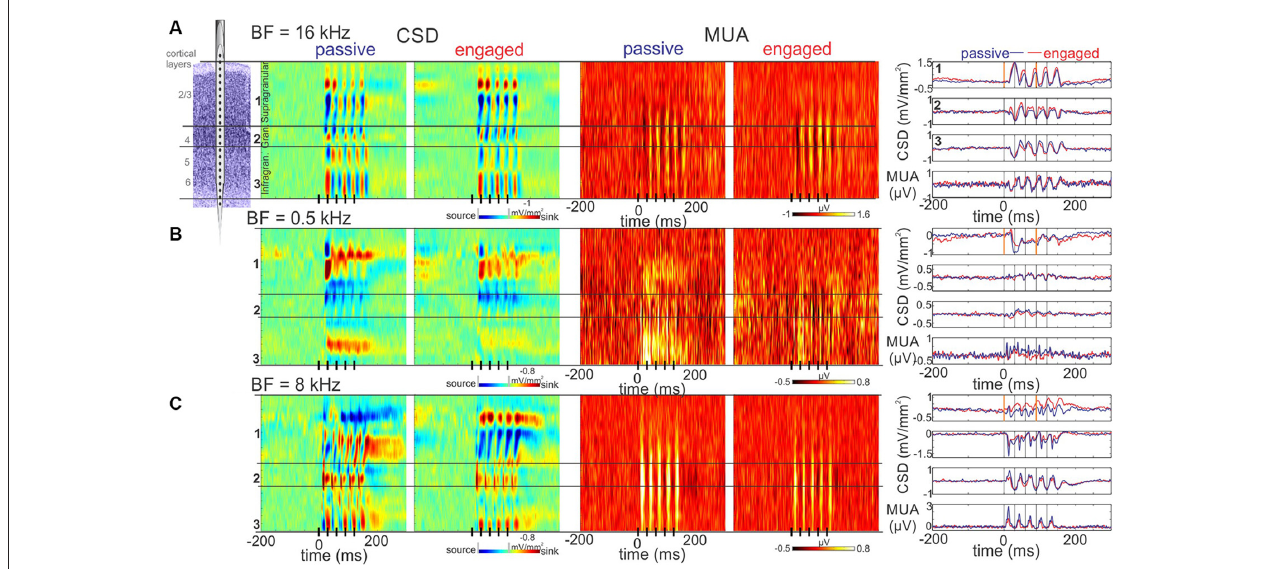
FIGURE 3 | Representative laminar response profiles. (A) Color-maps to the left display laminar Current source density (CSD) profiles in response to click-trains from an A1 site with a BF of 16 kHz (no suppression group). The boundaries of the supragranular, granular and infragranular layers are marked by black horizontal lines. The click-train is represented by black lines on the x -axis. Note that there appear to be sink (red)-source (blue) pairs representing active and associated passive currents in each of the layers. Color-maps to the right display the concomitant laminar MUA responses, which show a somewhat larger amplitude response in the engaged condition. The upper three traces to the right of the color-maps show CSD responses from the supragranular, granular and infragranular electrode locations marked by numbers to the left of the CSD maps (for the selection of these see “Materials and Methods” Section). The apparently largest response amplitude difference in passive vs. engaged condition is at the supragranular electrode location. Note that at stimulus onset, the baseline is negative-trending (especially in the engaged condition), and at the onset of the fourth click (orange line at 90.9 ms) the gamma frequency waveform (SSR) in between is also negative-trending. The bottom traces display the MUA averaged across all layers recorded in passive vs. engaged conditions. (B) Same as (A) , but from a low BF A1 site with significant engagement related suppression (suppression group). As opposed to (A) , the supragranular CSD in the engaged condition is positive trending at 0 ms, indicating an opposite phase low frequency excitability modulation. The slope of the SSR at 90.9 ms is negative trending. (C) Same as (A) , but from a relatively high BF A1 site with significant engagement related suppression. While similar to (A) , the baseline is negative trending, the SSR waveform is positive trending at the onset of the fourth click. This latter effect appears much stronger in the engaged condition. Note that in all three sites, MUA at stimulus onset is oppositely trending to the supragranular CSD, indicating that similar to what previous studies found, a negative CSD trend signals increasing, while a positive CSD trend signals decreasing excitability.